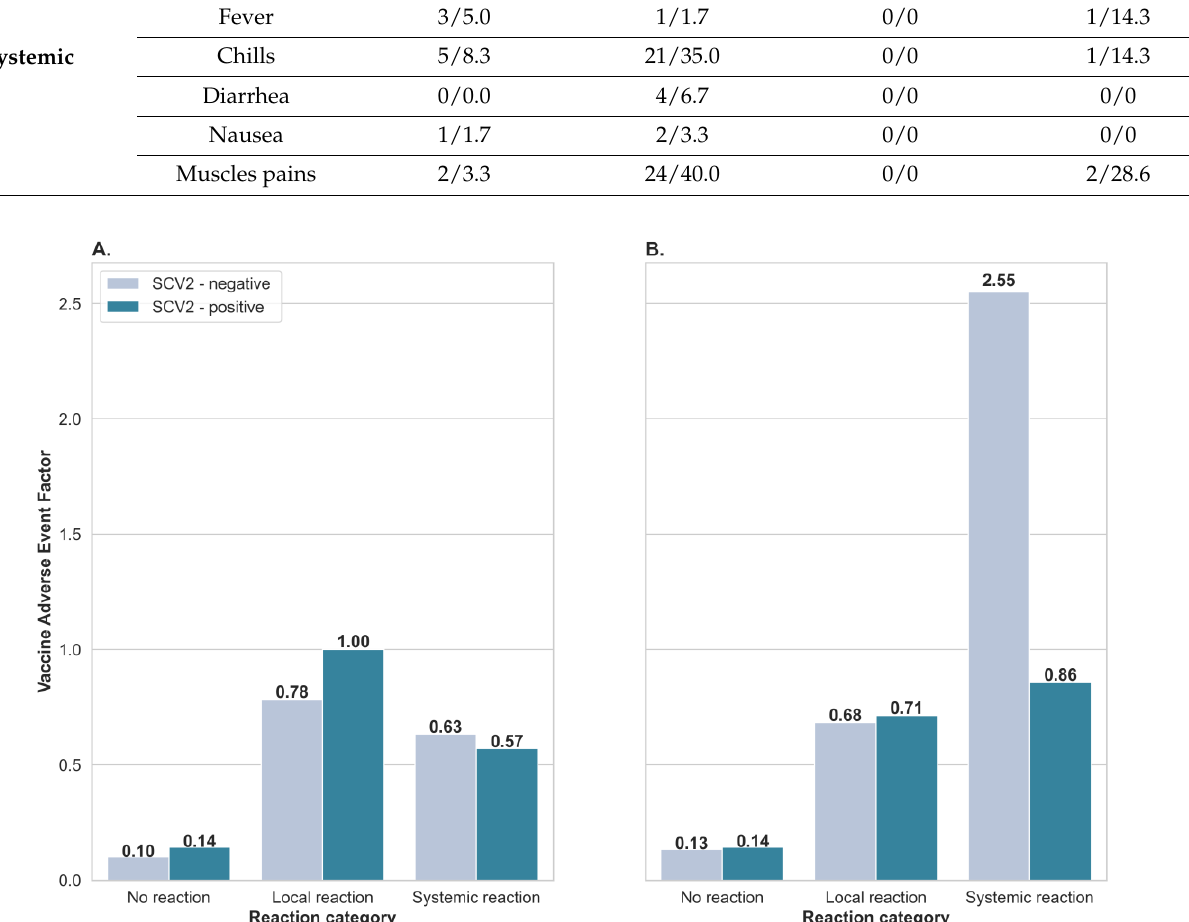
Figure 2. Comparison of Vaccine Adverse Event Factor after first ( A ) and second ( B ) vaccine doses, between participants presenting no reaction, local reaction, or systemic reaction in SCV2-negative and SCV2-positive groups, after administration of the BNT162b2 vaccine.